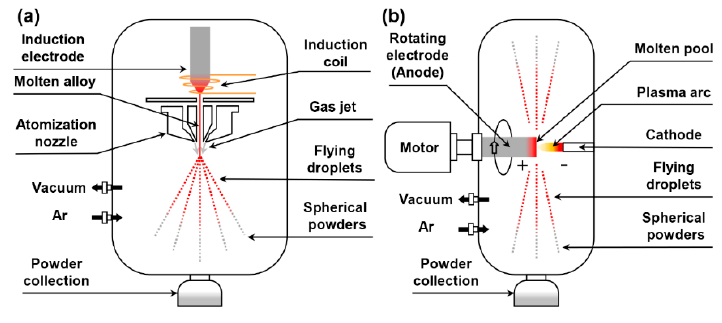
Figure 1. Schematic diagrams of the ( a ) EIGA and ( b ) PREP systems.